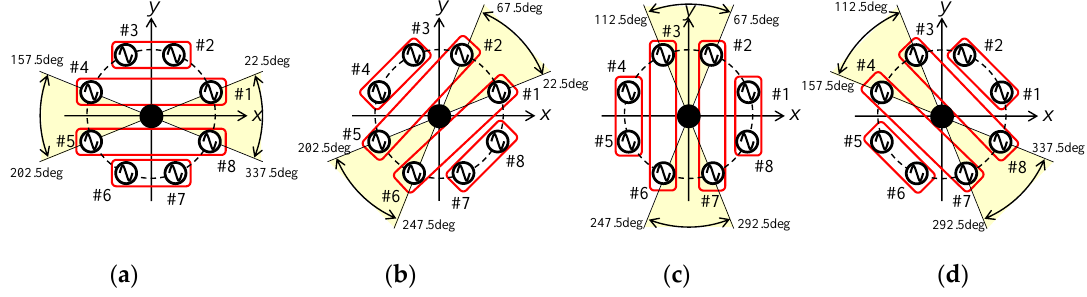
Figure 4. Combinations of the subarrays. ( a ) Combination1. ( b ) Combination2. ( c ) Combination3. ( d ) Combination4.